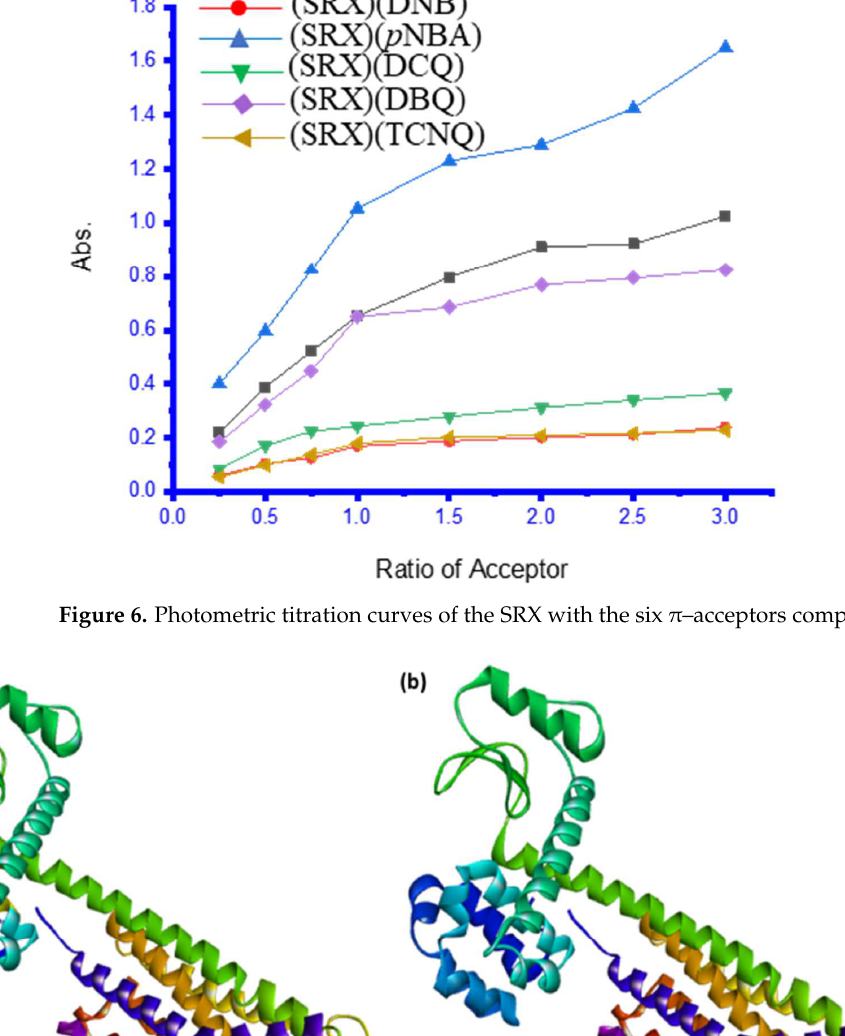
Figure 6. Photometric titration curves of the SRX with the six π–acceptors complex [4].